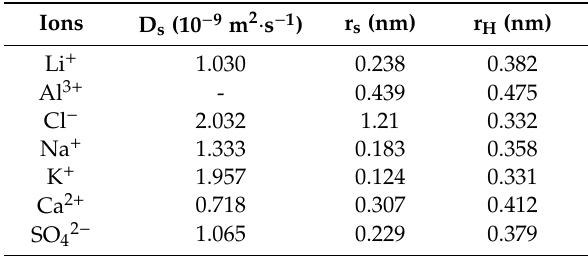
Table 5. Di ff usion coe ffi cients, Stokes radii, and hydrated ionic radii of ions [38].